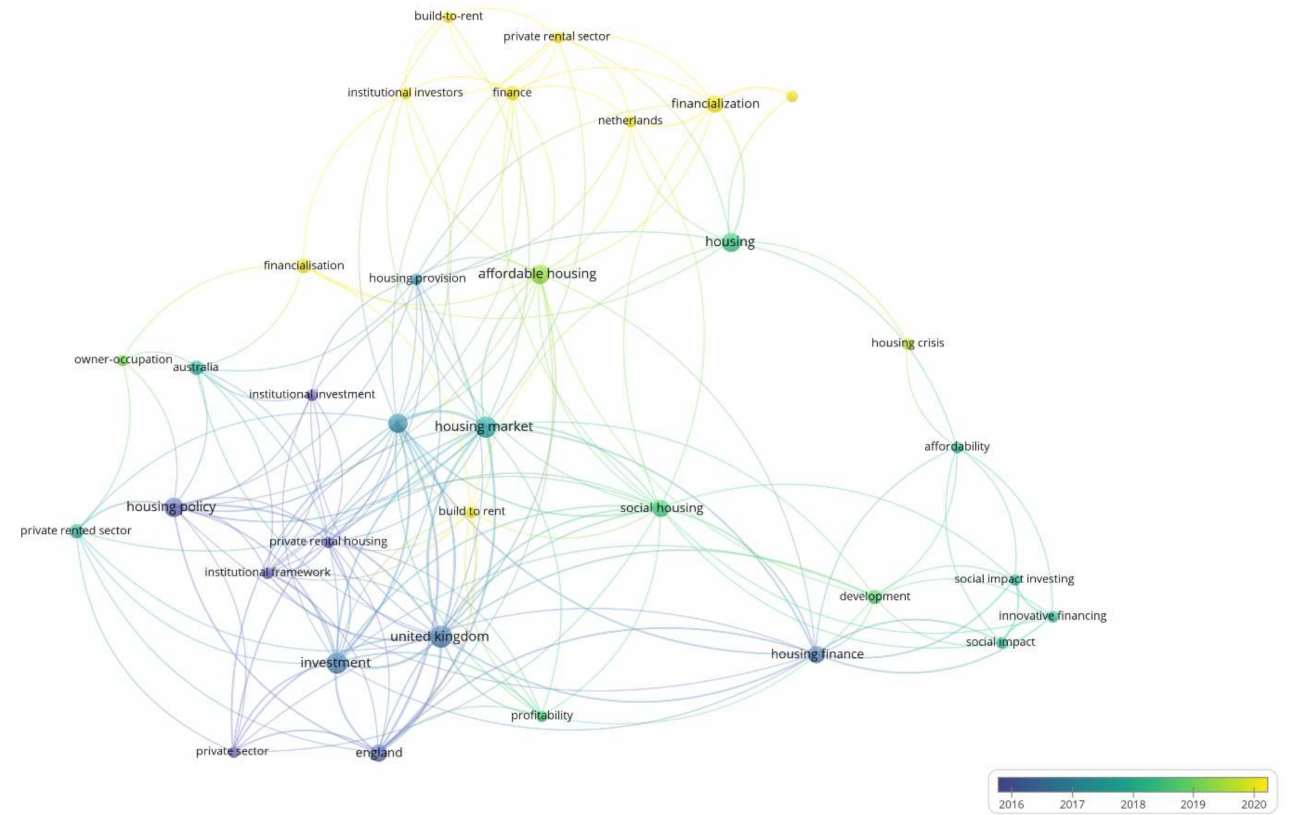
Figure 1. Scientometric mapping of keywords of BTR research.